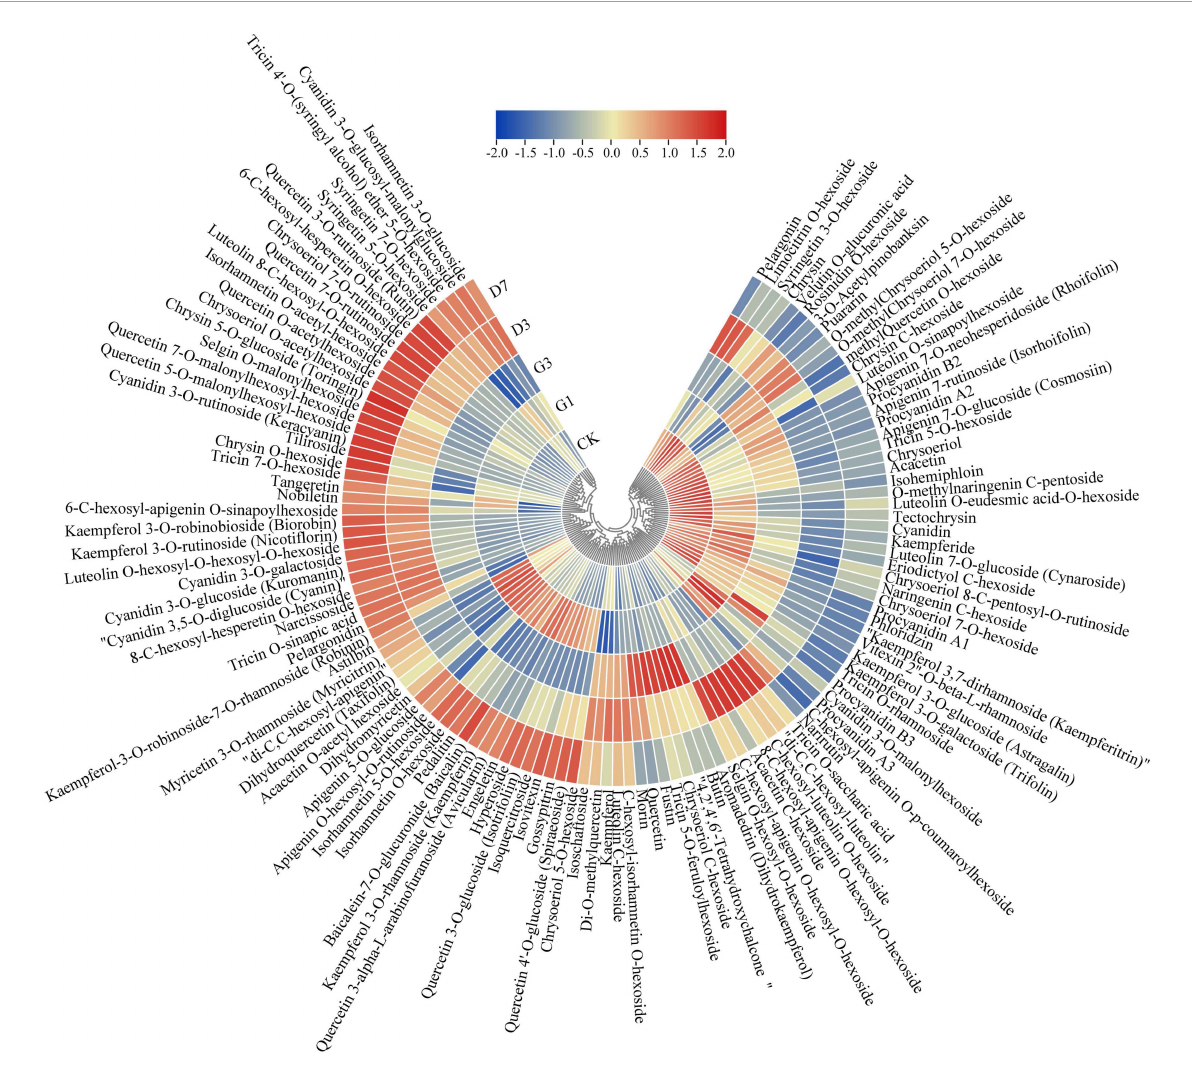
FIGURE5 Expression of flavonoid metabolites in the different treatments. Gene expression data were normalized and plotted using Tbtools V1.075